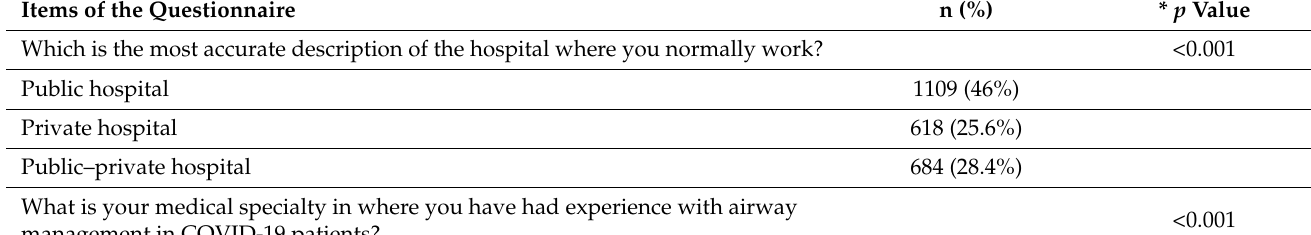
Table 2. Profile of the physicians who participated in the